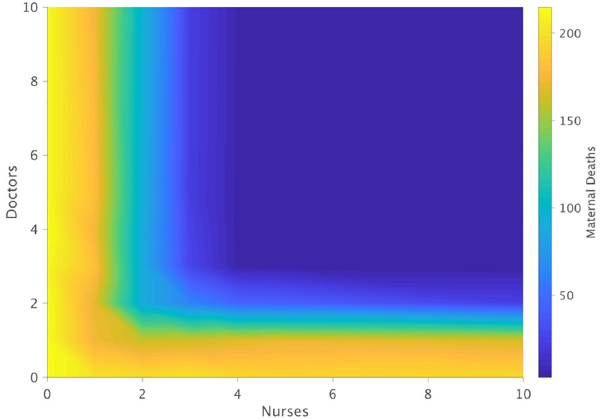
Fig 9. Predicted effect of staffing combinations for nurses and doctors when staffed consistently across morning, evening, and night shifts. Data depicts mean maternal deaths for each staff combination over n = 50 identical simulations of over a simulated timeframe of 3 months with 20,000 IU of oxytocin and 2200 mg/mL of hydralazine being supplied each month.